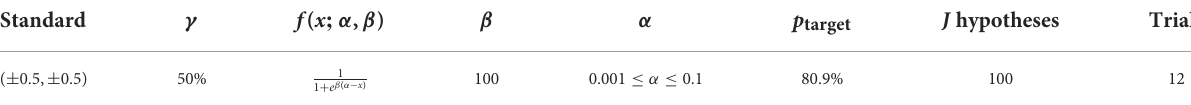
TABLE 1 Proposed values for a standardized maximum likelihood procedure (MLP) to evaluate two-dimensional sonification designs. Standard